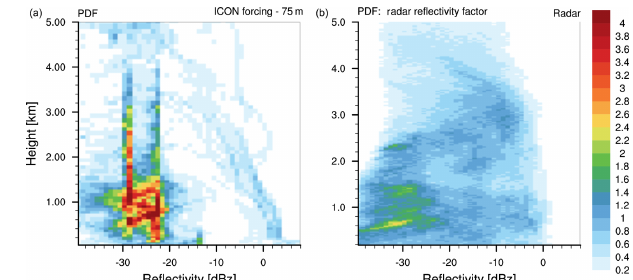
reflectivities for all 11d (14–24 June 2017). The PDF (%) of each height is based on the maximal possible number of data points (nor-